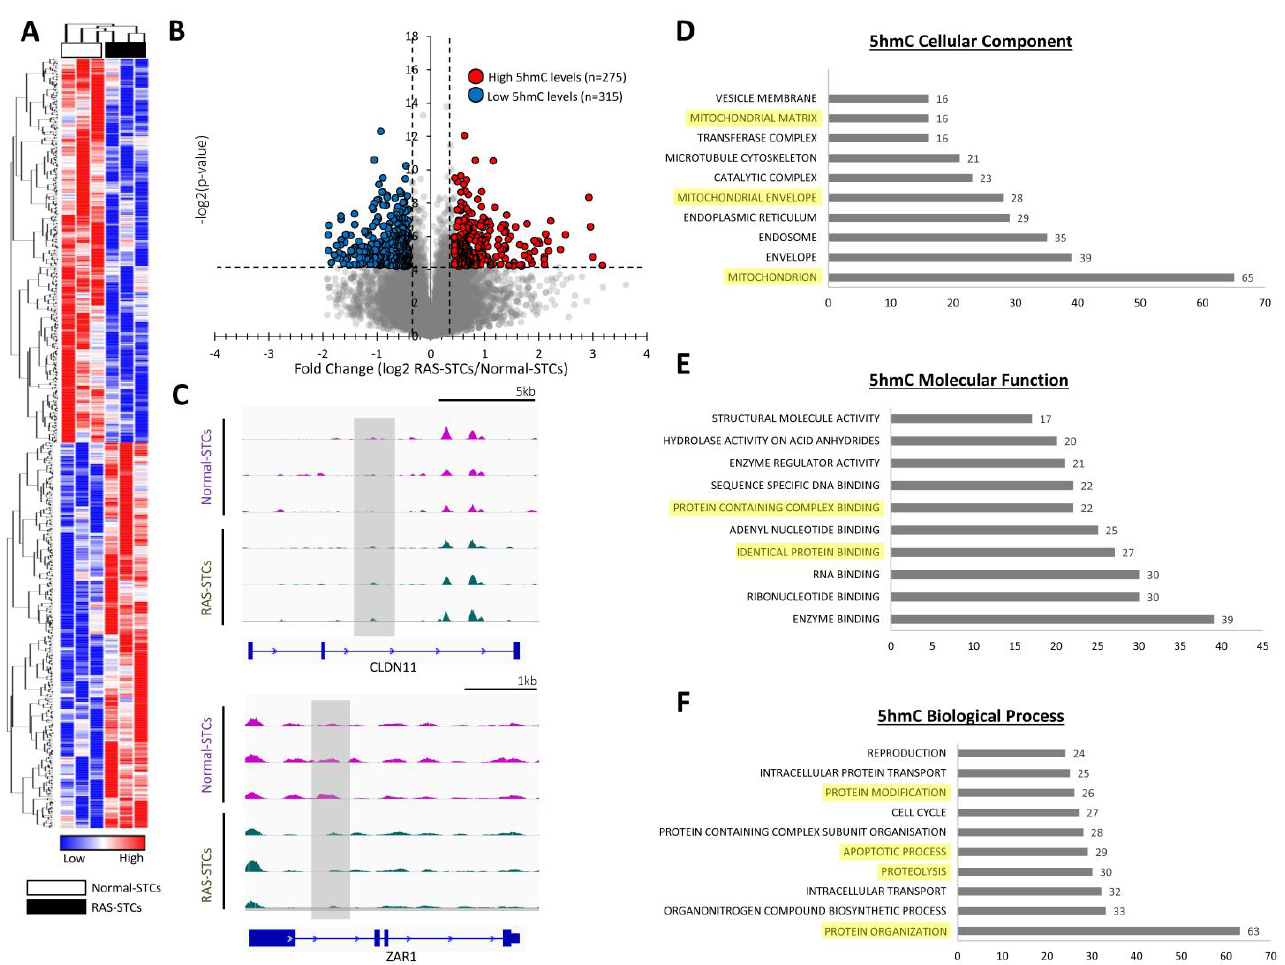
Figure 3. RAS induces significant changes in 5-hydroxymethylcytosine (5hmC) levels in swine STCs. ( A ): Heat map of genes with significant changes in 5hmC levels between Normal- and RAS-STCs. ( B ): Volcano plot of dysregulated 5hmC genes. Genes with higher ( n = 275) and lower ( n = 315) 5hmC levels in RAS- versus Normal-STCs are shown with red and blue dots, respectively. ( C ): Representative reads for CLDN11 and ZAR1 genes in Normal- and RAS-STCs. D–F: Gene ontology (GO) analysis of cellular component ( D ), molecular function ( E ), and biological process ( F ) of genes with significant changes in 5hmC levels between Normal- and RAS-STCs.